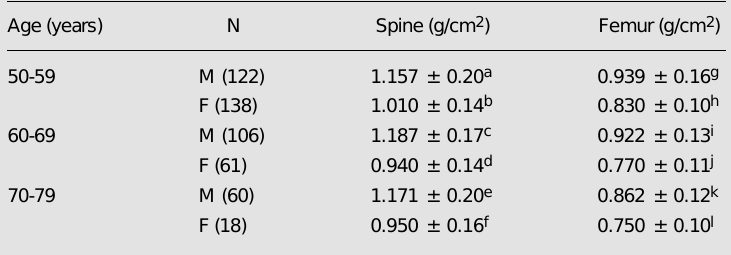
6 - Comparison of Brazilian male (M) and female (F)* populations for lumbar spine and femoral neck bone mineral densities stratified by decade. Data were analyzed statistically by the Student t -test. P<0.0001 for a x b, c x d, e x f, g x h, and i x j. P<0.0007 for k x l. *Brazilian female population from Ref. 11.